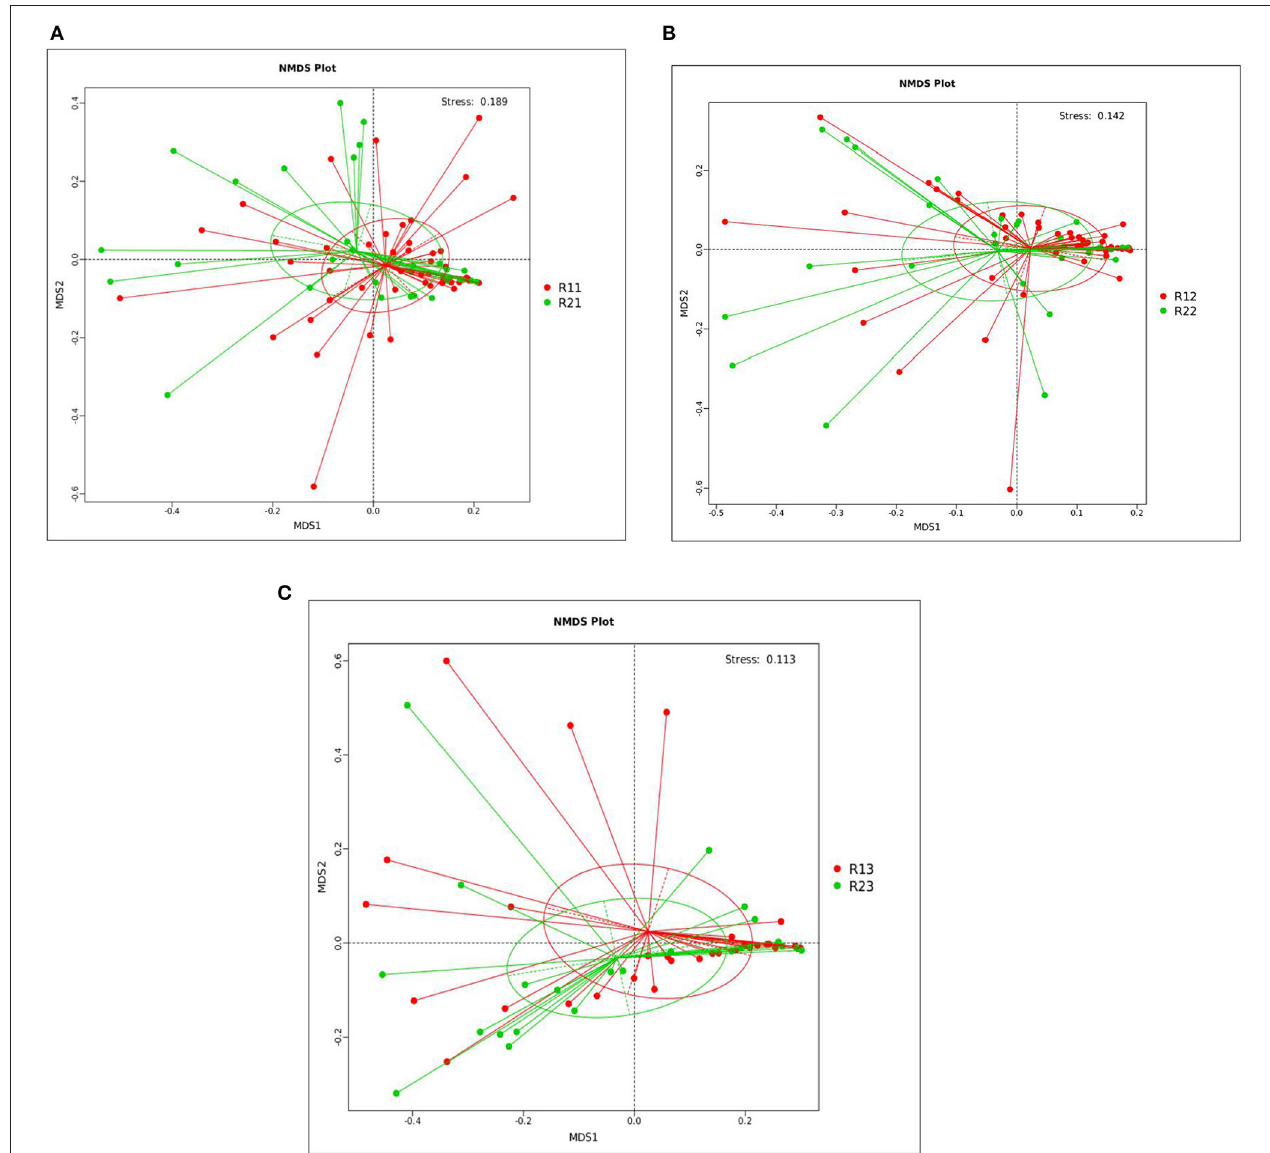
FIGURE 1 | NMDS analysis between the study and control groups on days 1, 3, and 5. (A) NMDS analysis between the two groups on day 1. (B) NMDS analysis between the two groups on day 3. (C) NMDS analysis between the two groups on day 5. Each point in the diagrams represents a sample, the distance between two points indicates the degree of difference, and samples in the same group are represented by the same color. When the stress is < 0.2, it indicates that NMDS could accurately reflect the degree of difference between samples. The species information contained in the samples is reflected in the multi-dimensional space in the form of points, while the degree of difference between different samples is reflected in the distance between points, which can reflect the differences between groups and within groups of samples. NMDS, non-metric multi-dimensional scaling; R11, gut flora of the study group on day 1; R21, gut flora of the control group on day 1; R12, gut flora of the study group on day 3; R22, gut flora of the control group on day 3; R13, gut flora of the study group on day 5; R23, gut flora of the control group on day